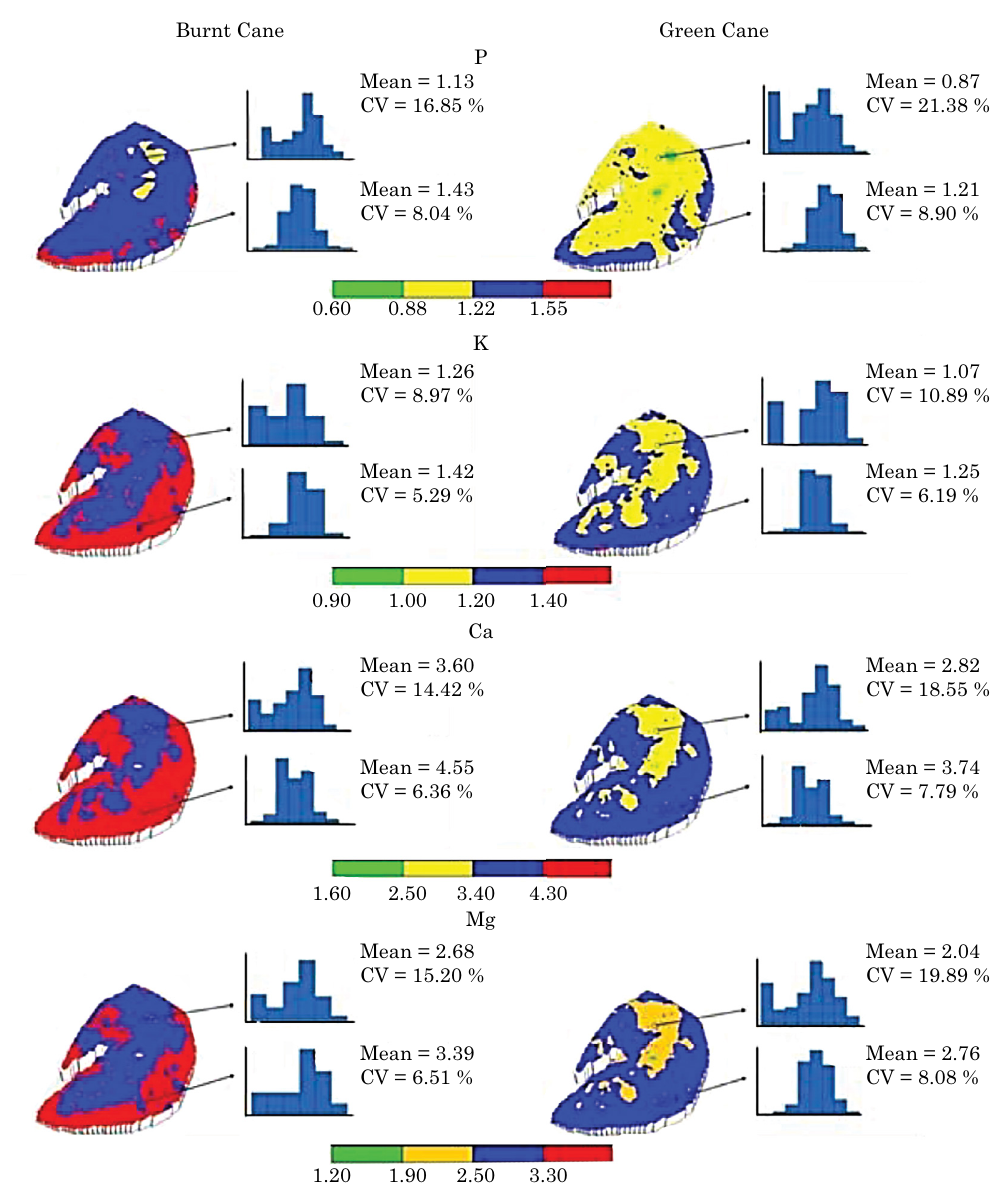
figure 2. e-type estimates of p, K, ca, and Mg soil depletion rates in burnt and green sugarcane harvest scenarios stems.